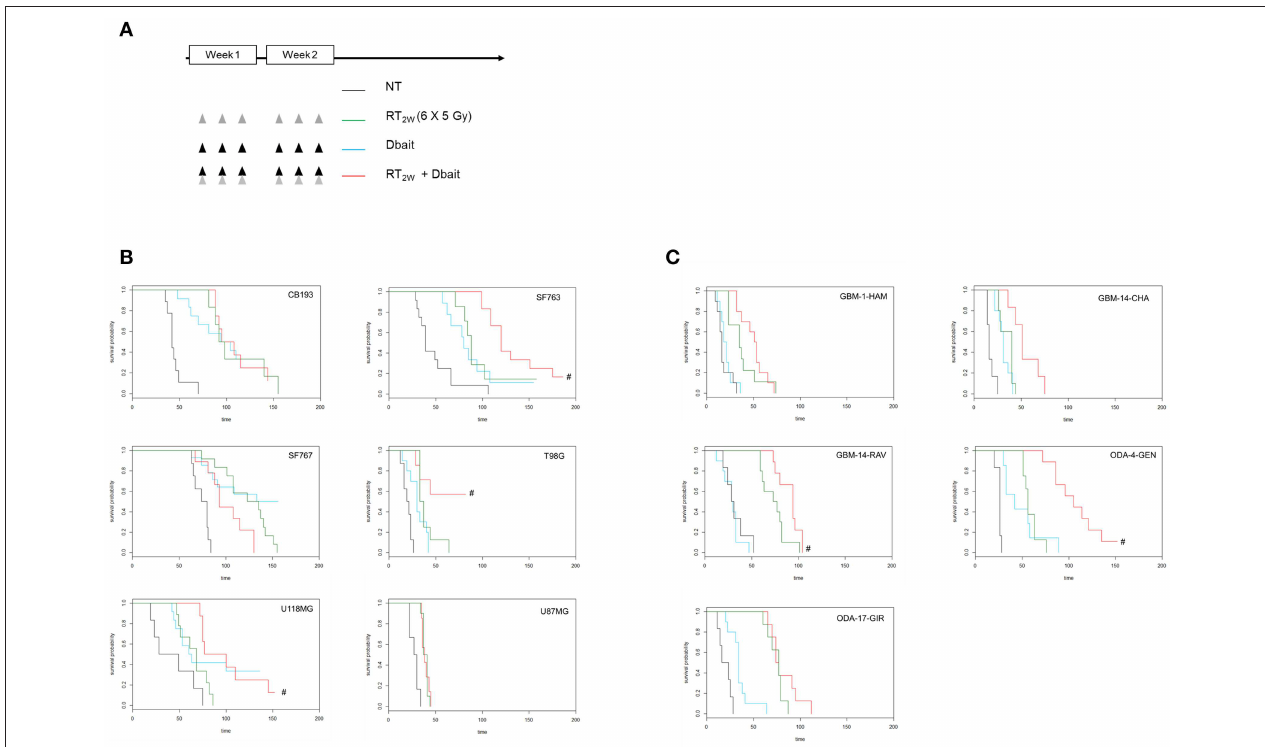
FIGURE 4 | Effect of Dbait combined with radiation in vivo . (A) Xenograft models were treated with hypofractionated radiotherapy (RT; 6x5Gy in 2 weeks; green), Dbait (6 local administrations in 2 weeks; blue) or a combination of Dbait and RT (red) or untreated (black). For Cell lines Derived Xenografts (CDX, B ) and for Patient Derived xenograft (PDX, C ) the survival curves of groups were plotted according to the Kaplan–Meier method. The survival fraction of groups was compared using log-rank test. # p < 0.05 between RT 2w and RT 2w +